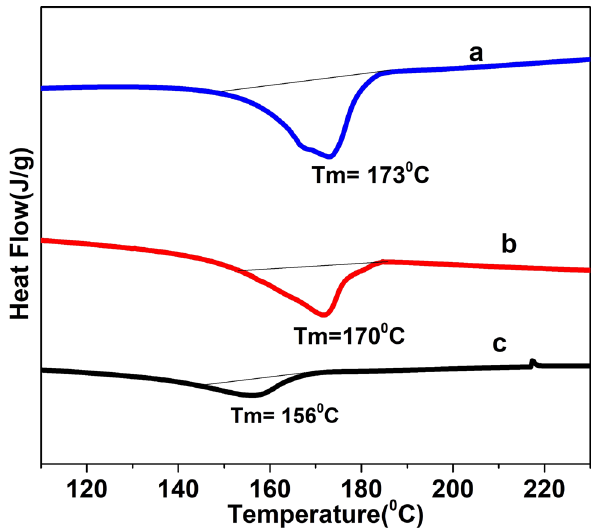
Fig. 5 Thermogravimmetry (TGA) of a PVdF, b PVdF–PMMA (80– 20) and c PVdF–PMMA (50–50) nanofibrous